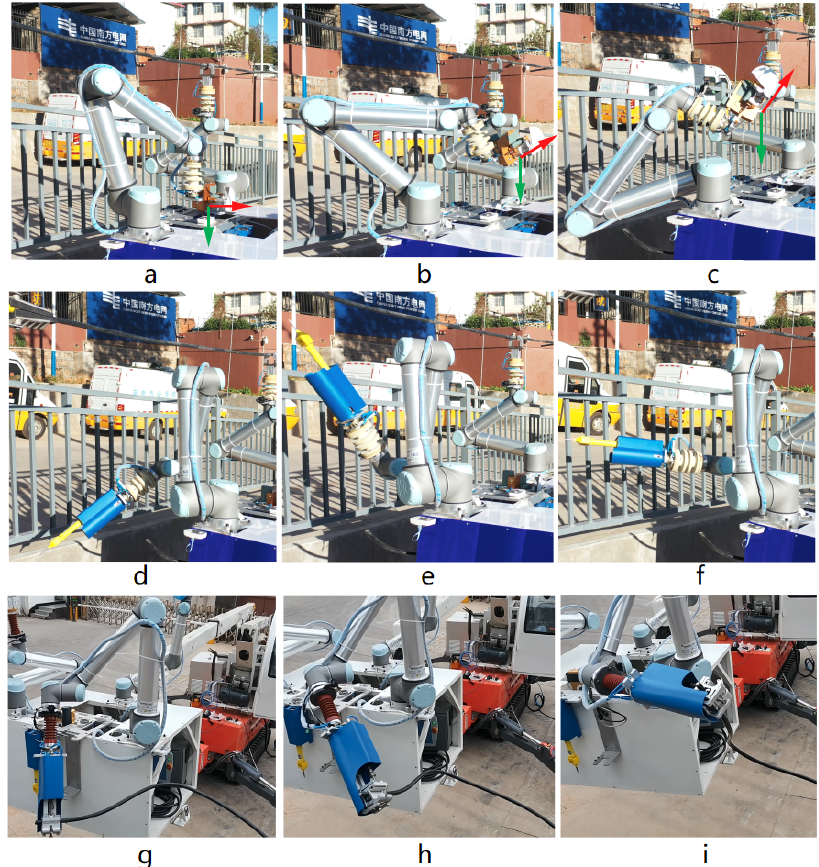
Figure 23. The impact of planning algorithms on the task process. ( a – c ) During the stripping operation, the non-fixed parts should be kept open during the tool removal operation. ( d – f ) During the movement of the long tool, each joint of the robot is in a proper state of force and the load capacity is improved. ( g – i ) During the installation of the cable, the robot body maintains the principle cable to prevent entanglement.)